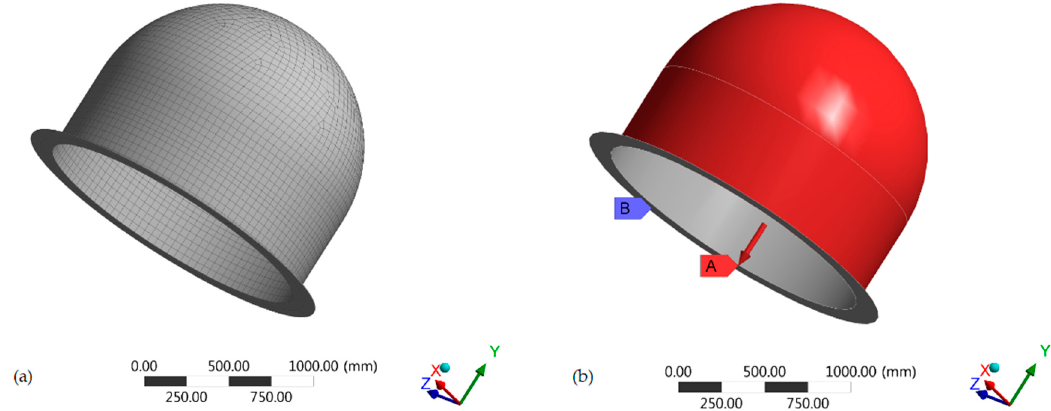
Figure 1. ( a ) Meshing of the radome model; ( b ) boundary and loading conditions of the radome